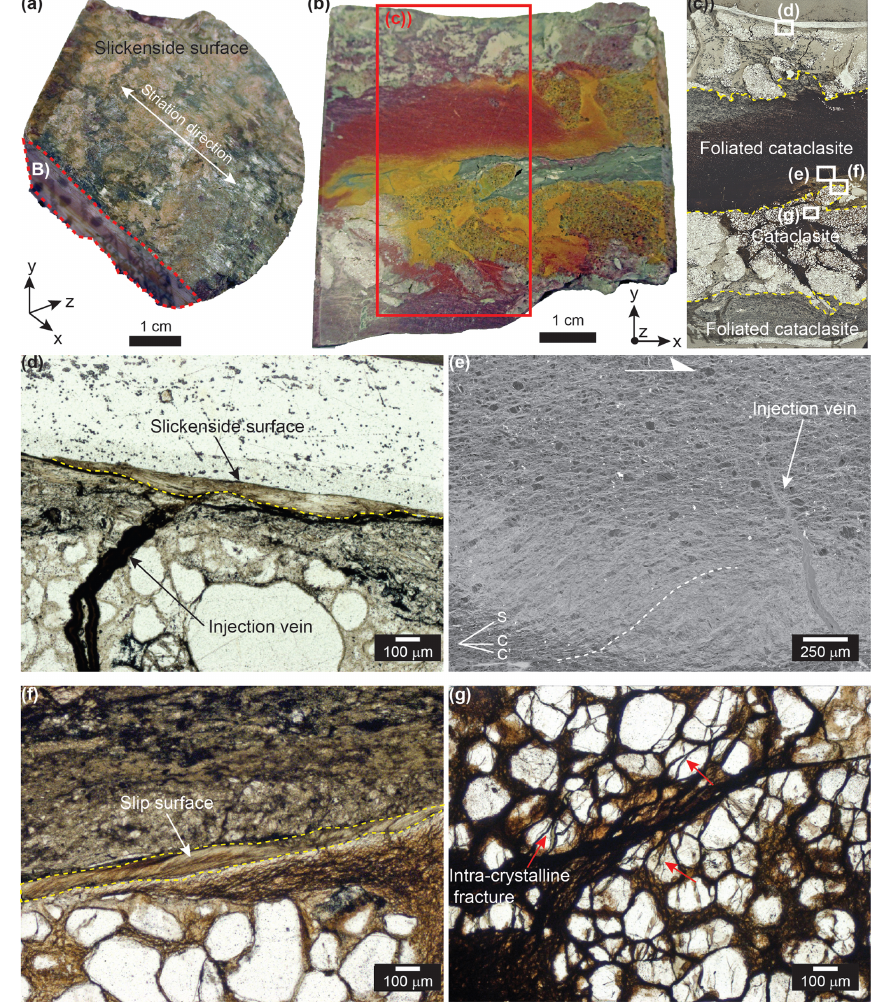
Figure 5. Faulted sample from Dobbyn 2 well (depth 441m). (a) Hand specimen showing green–beige slickenside surface with striations due to frictional movement along the surface. (b) Polished face of the hand specimen cut parallel to the shear direction as inferred from the striation direction shown in (a) . (c) Whole thin section image collected using an optical microscope in plane polarized light. The position of the thin section with respect to the hand specimen is shown by the red rectangle in (b) . The dashed yellow line marks different microstructural domains of the fault rock defined as (i) foliated cataclasite and (ii) cataclasite. White boxes indicate the location of the following images. (d) Optical microscope image in plane polarized light showing the slickenside surface (bound by the dashed yellow line) of the samples composed of iso-aligned phyllosilicates. Also shown is a hematite-rich injection vein. (e) Scanning electron microscope image of the foliated cataclasite portion of the samples and the characteristic S–C–C (cid:48) texture (see text for details). The dashed white line highlights the orientation of the S planes. (f) Optical microscope image in plane polarized light showing a slip surface (bound by the dashed yellow line) at the boundary between the foliated and non-foliated cataclasite domains. (g) Optical microscope image in plane polarized light showing a network of hematite-filled intra-crystalline microfractures in the cataclasite domain of the fault rock, mainly composed of quartz (white grains) and pore-filling